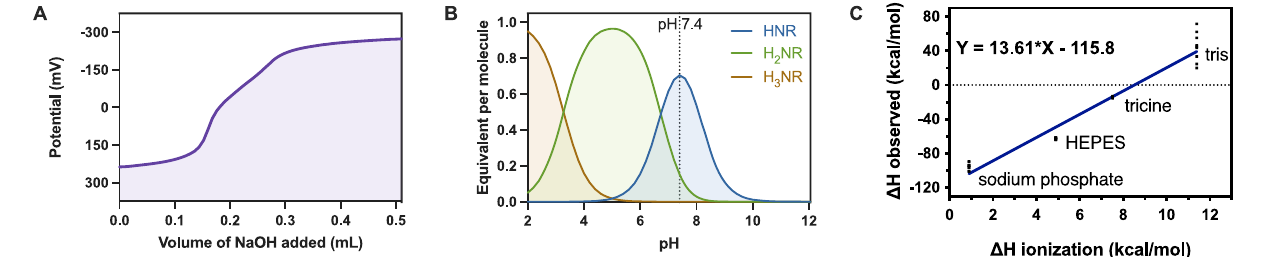
Fig. 2 | Observed enthalpy in different buffer environments compared to heat of ionization shows recruitment of protons upon MPI binding to polyP. A Evaluation of free unbound MPI charge content. Potentiometric titrations were used to evaluatethe chargecontentofthe MPIlibraryat25°Cand 160mM NaCl.A sample titration of 0.15M NaOH into a solution of acidi fi ed MPI 3 while measuring